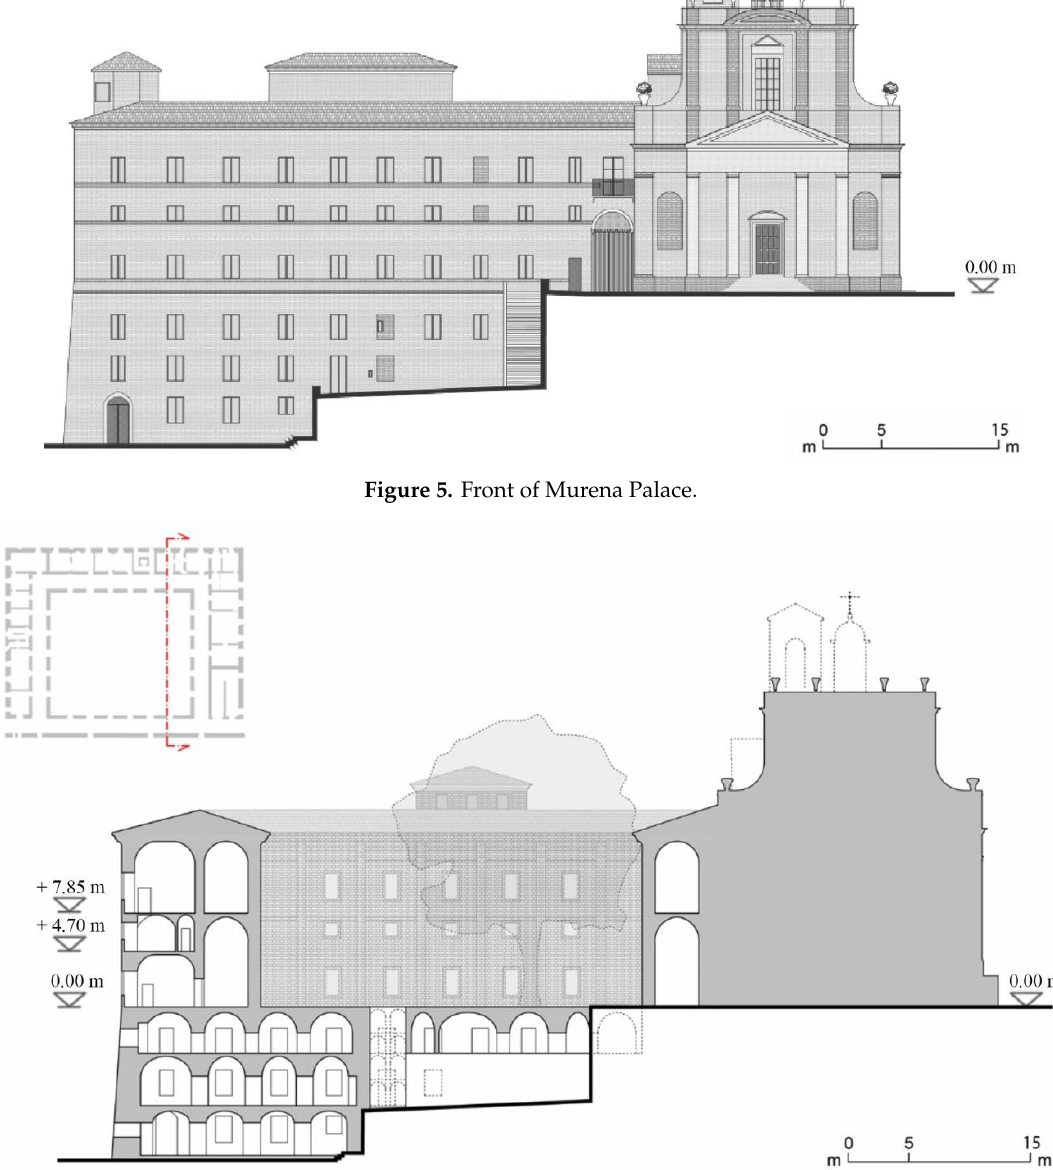
Figure 6. Section of Murena Palace.